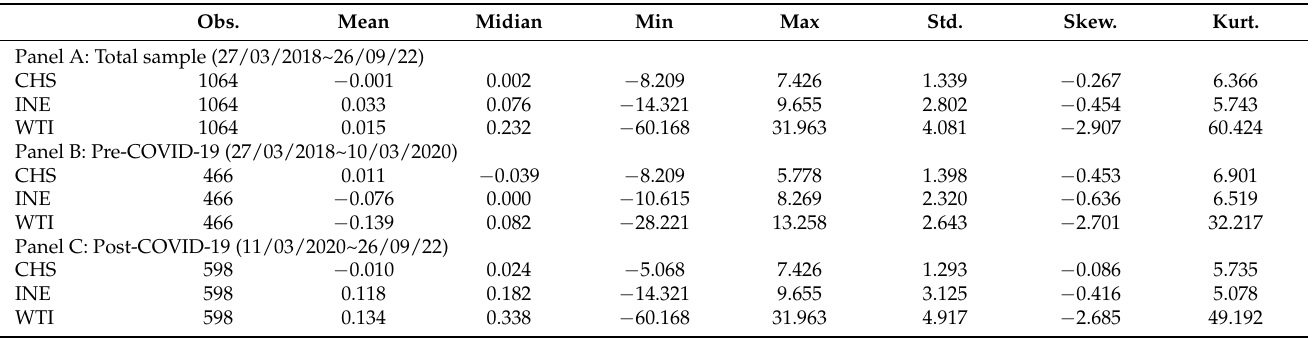
Table 1. Descriptive statistics.